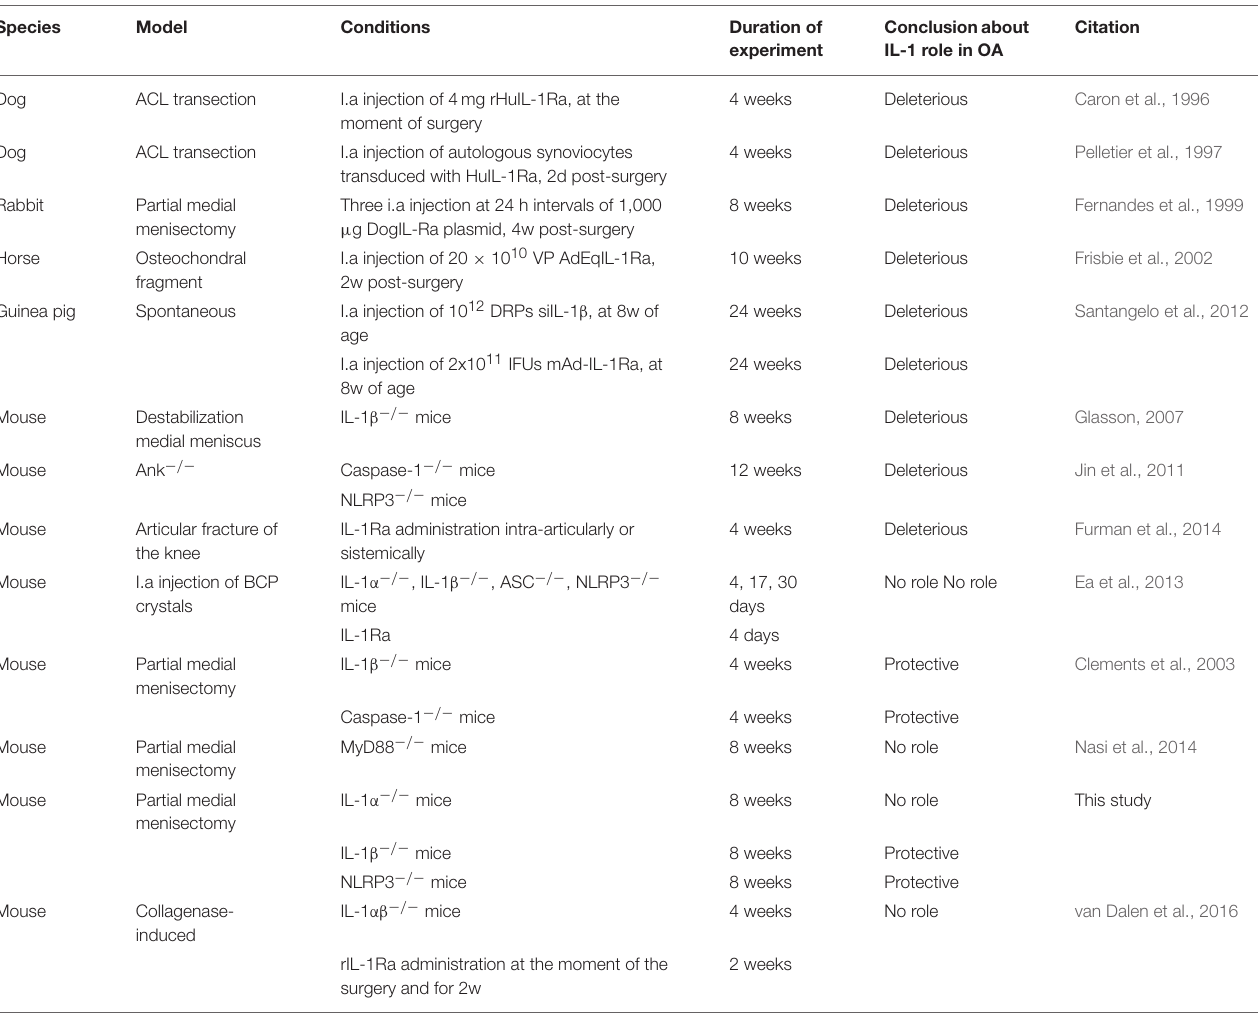
TABLE 2 | Summary of studies in animal models of OA where IL-1 role has been tested.